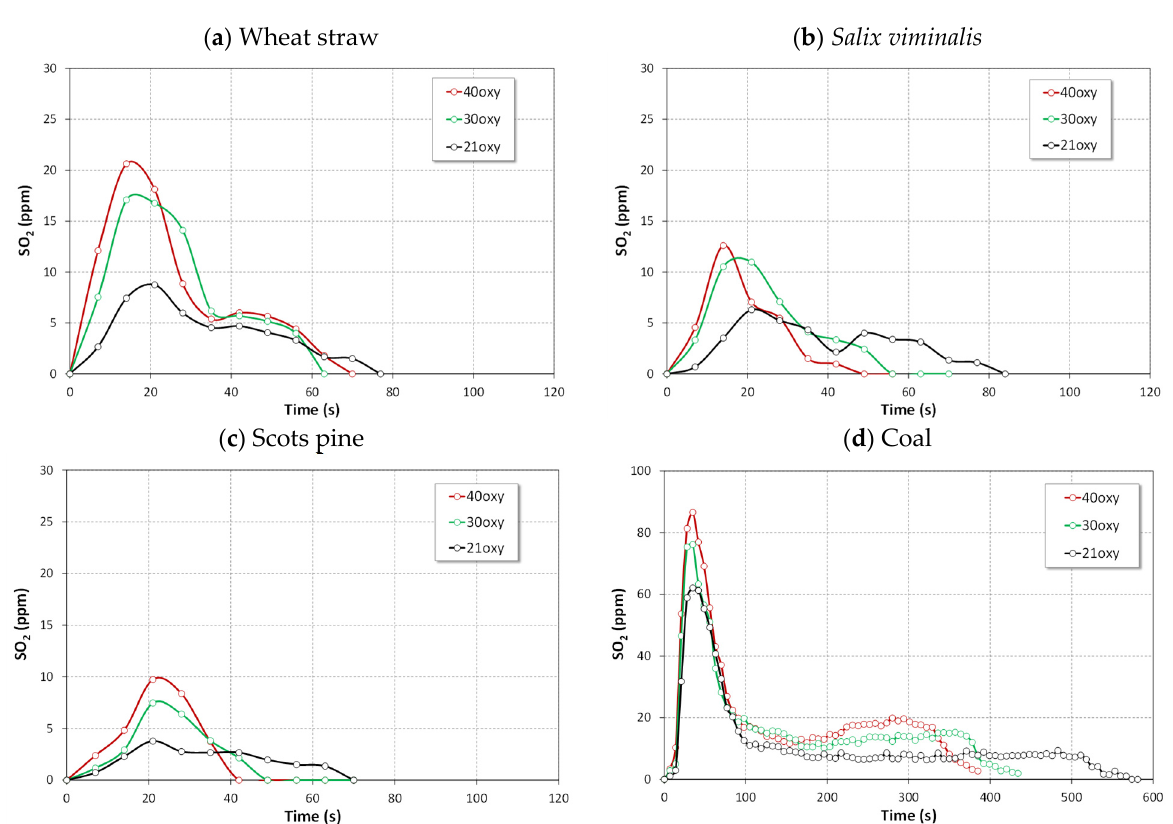
Figure 15. The instantaneous concentrations of SO 2 during oxy-combustion of the tested fuels.